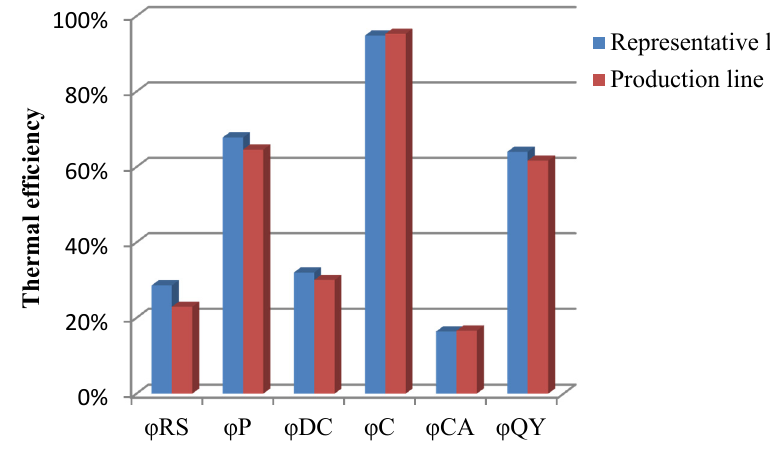
Figure 8. Comparison of thermal efficiency.